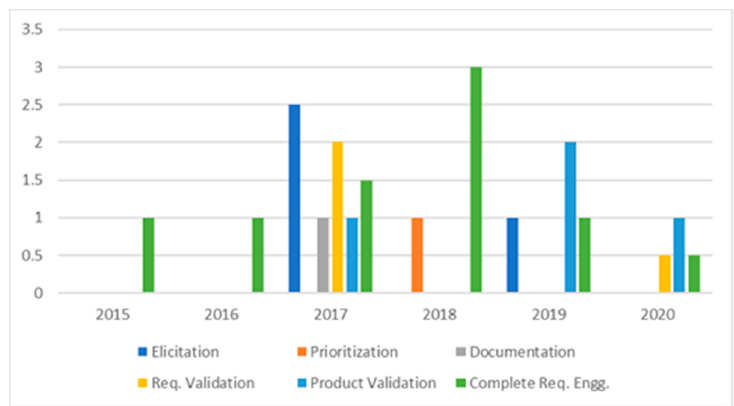
Figure 2. Research evolution in terms of activities focused.